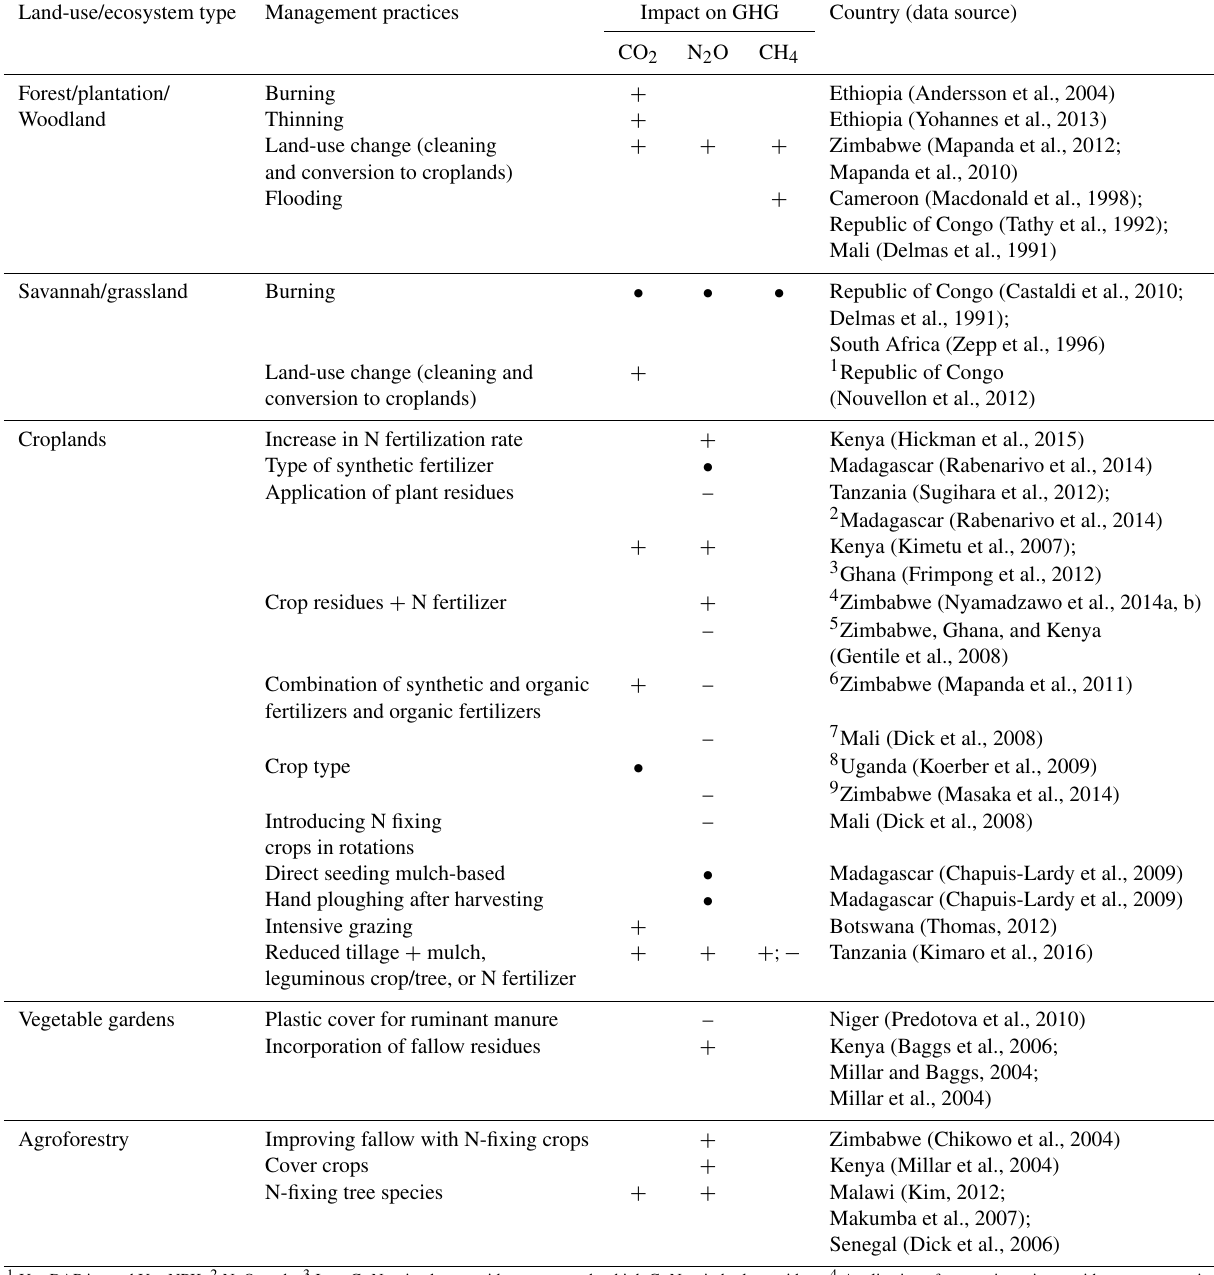
Table 4. Summary of the effect of management practices on greenhouse gas (GHG) emissions. + indicates increasing, • indicates no change, and – indicates